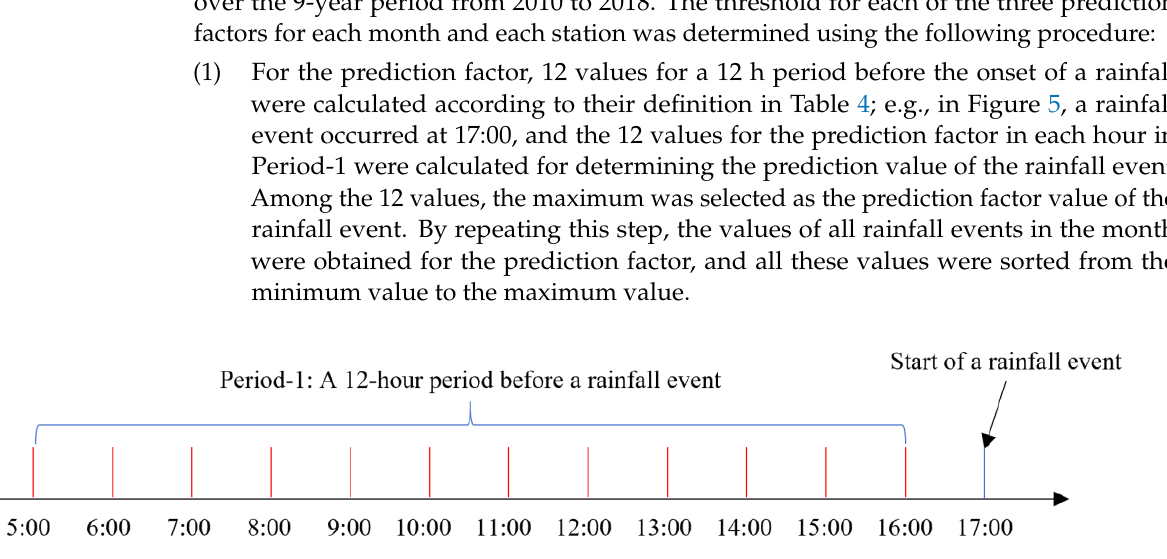
Figure 4. Variation in GNSS-PWV before rainfall events in June 2015 at the 726140-54742-VTD7 sta- Figure 4. tion. Table 4. Definition of the three prediction factors.